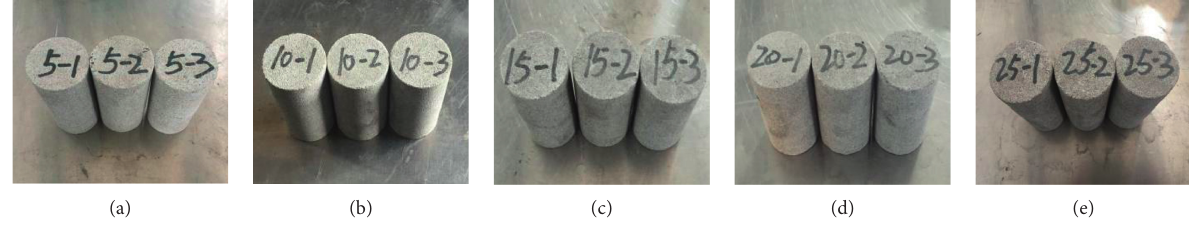
Figure 3: Apparent properties of the feldspar sandstones (group A) after a water-rock dry-wet cycle. (a) 5T. (b) 10T. (c) 15T. (d) 20T. (e) 25T.